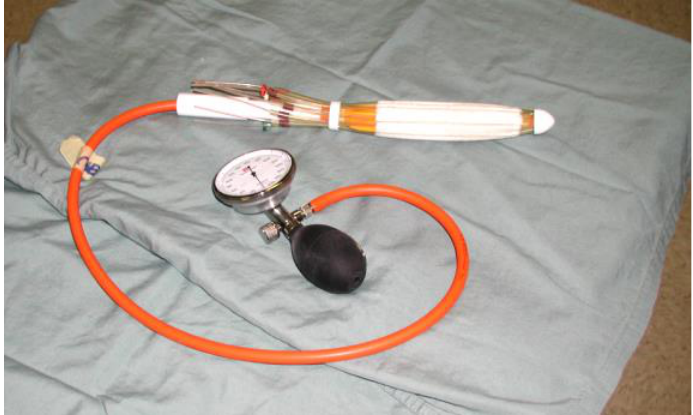
Figure 1. Novi Sad [13] endorectal applicator (Nucletron Corp., Columbia, MD,